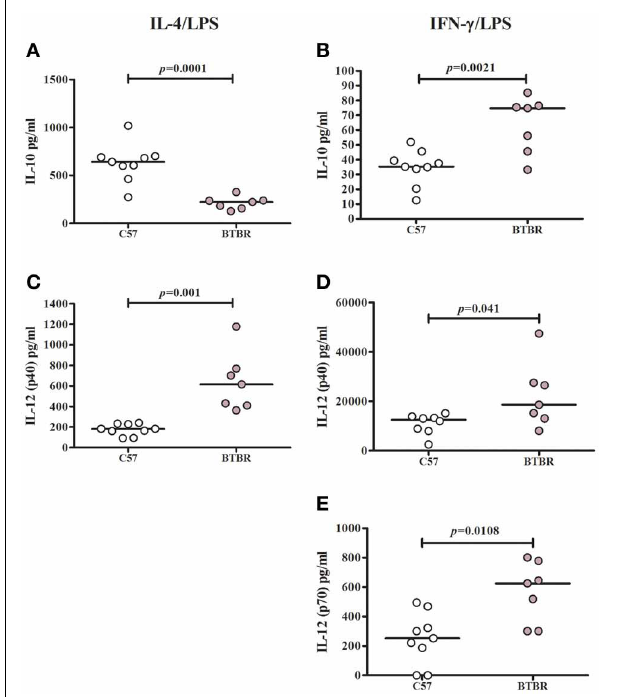
FIGURE 1 | M1 and M2 cytokine polarization in BTBR and C57 macrophages. Scatter graphs and median values of IL-10 (A,B) , IL-12p40 (C,D) and IL-12p70 (E) after IL-4/LPS incubation (A,C) and IFN γ /LPS incubation (B,D,E) . IL-12(p70) values were below observable levels